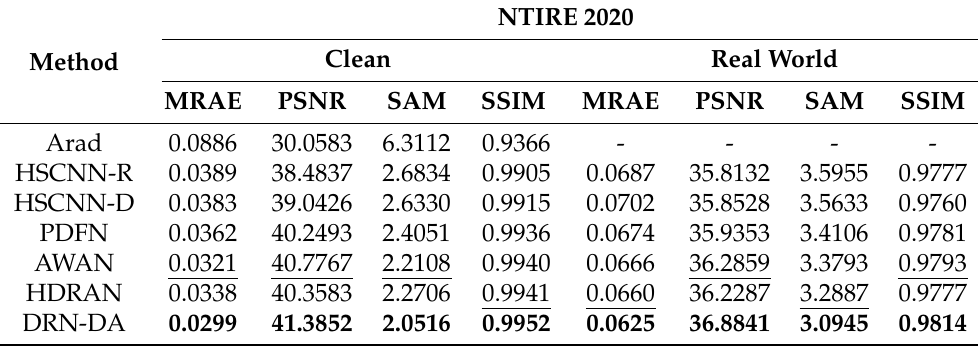
Table 2. Comparison between the proposed method and other state-of-the-art methods without the ensemble strategy based on the NTIRE 2020 data sets.